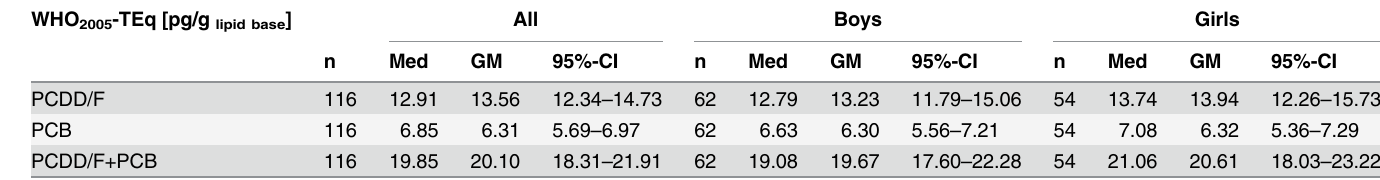
n = numbers; Med = median; GM = geometric mean; 95%-CI = 95% con fi dence interval of GM.